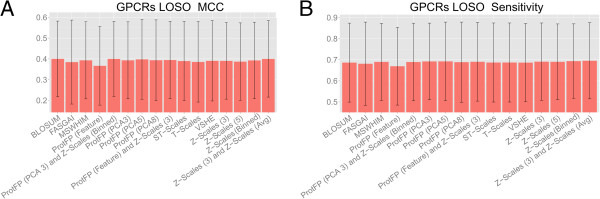
Mean performance of the benchmarked descriptor sets in the GPCR LOSO validation experiments. The mean is calculated over all 32 receptors and the error bar represents the standard deviation. Shown are the MCC (A) and the sensitivity (B). Note that error bars are large due to different performance between models trained on different GPCRs, not between repeats of the individual models. Here extrapolation takes place on the target side as the test set contains unseen targets. The differences between individual descriptor sets are small. Again for individual receptors larger performance differences occur (see main text and Additional file
1: Figure S11 for details). In this case, Z-Scales (3) and Z-Scales (Avg) is the descriptor set exhibiting best performance while ProtFP (Feature) performs the worst.